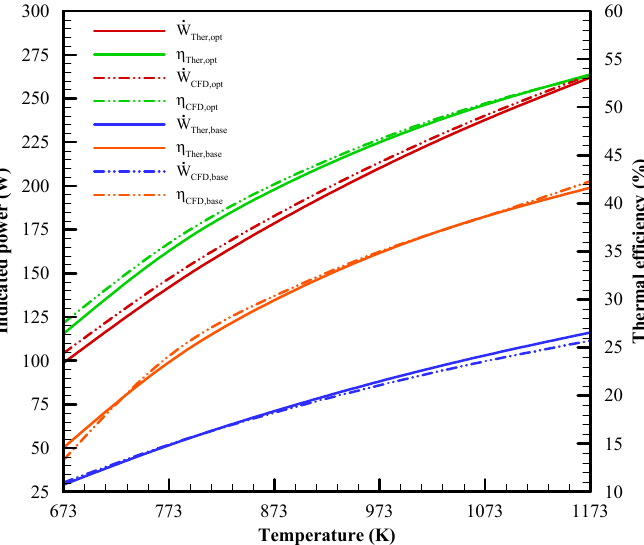
Figure 6. Variation of the optimal engine performance with heating temperature.